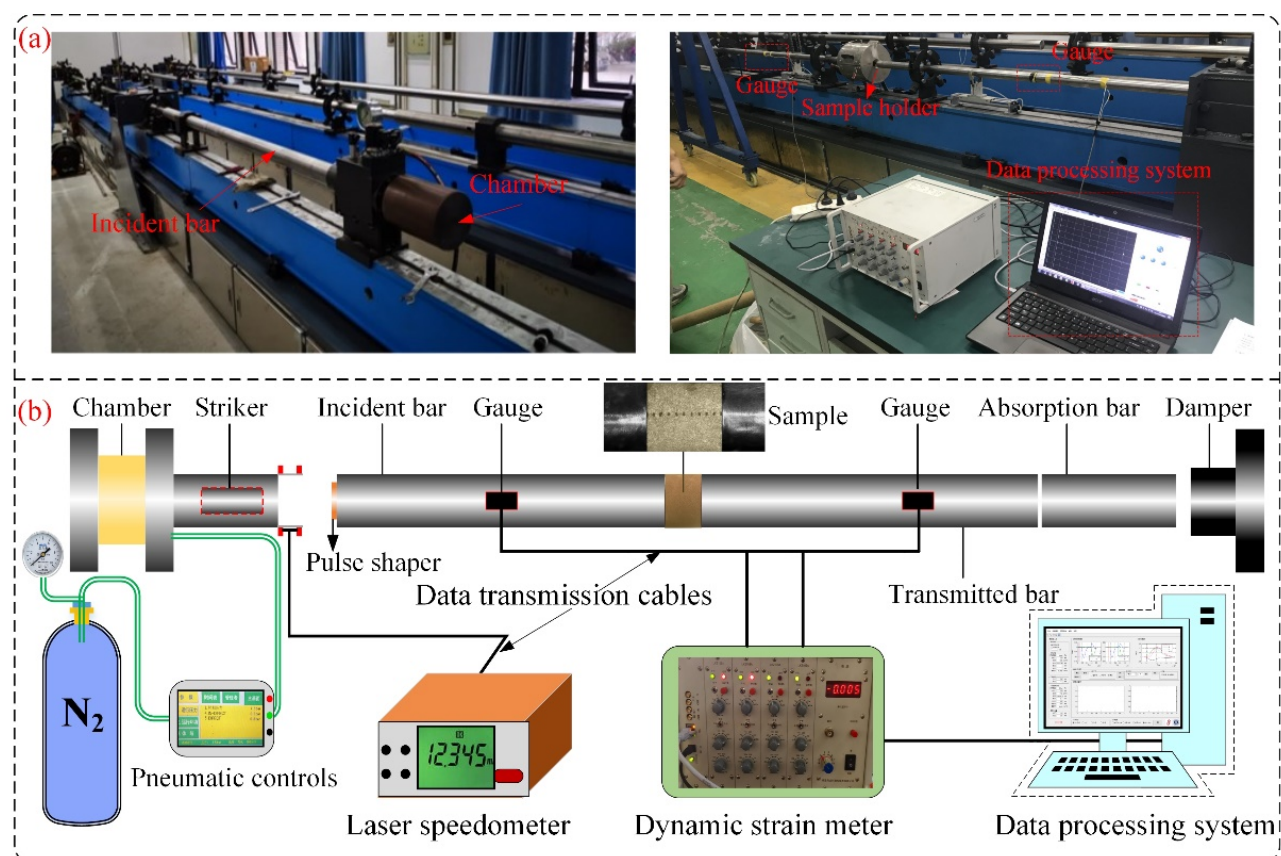
Figure 6. SHPB experimental system ( a ) and detailed schematic diagram ( b ).